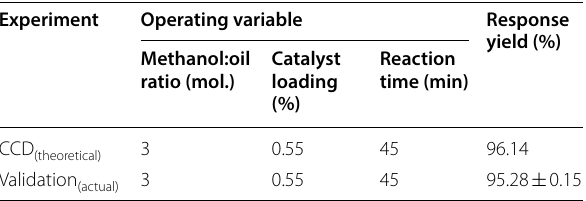
Table 8 Optimization and validation of biodiesel